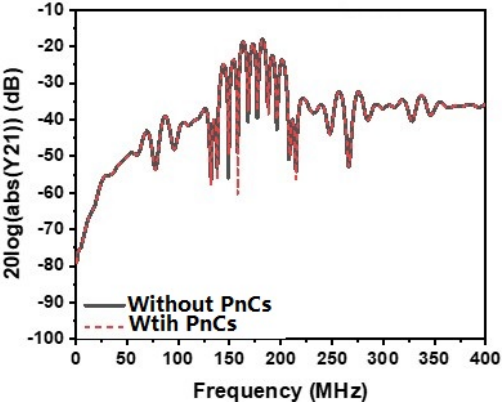
Figure 6. Transmission of the Love wave mode delay line.